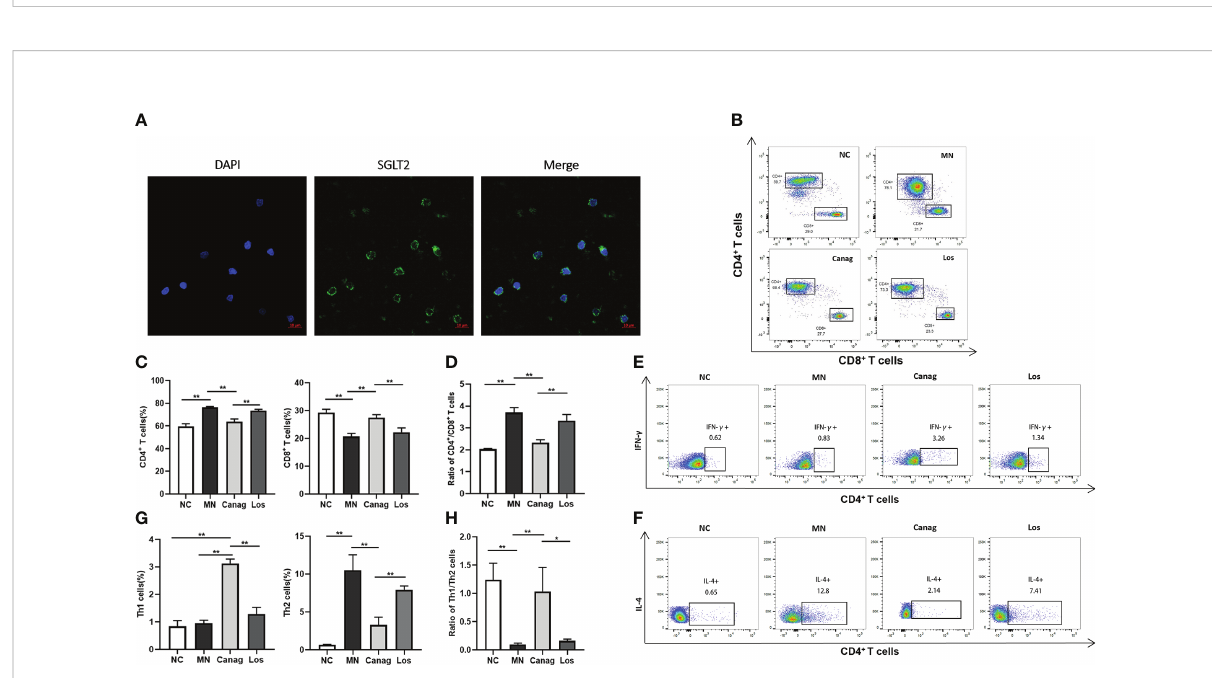
FIGURE 3 Canagli fl ozin regulates the imbalance in Th1/Th2 in MN rats. (A) Representative images showing DAPI (blue) and SGLT2 (green) staining in vitro T lymphocytes. (B – D) The number of CD4+ T-cells and CD8+ T-cells in peripheral blood PBMCs of rats detected by fl ow cytometry analysis. (E – H) The number of Th1 cells and Th2 cells in peripheral blood PBMCs of rats detected by fl ow cytometry analysis. Data are shown as mean ± SEM values. One-way ANOVA followed by Tukey ’ s test for multiple comparisons was used. *P < 0.05, **P < 0.01.